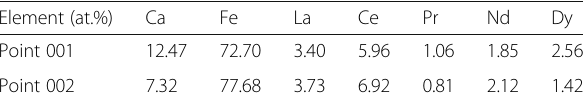
Table 1 EDS results from points 001 and 002 in Fig. 5b of RE 13.6 Fe 78.4 B 8 with 7wt.%Dy 2 O 3 and 2.3wt.%Ca co-dopants Element